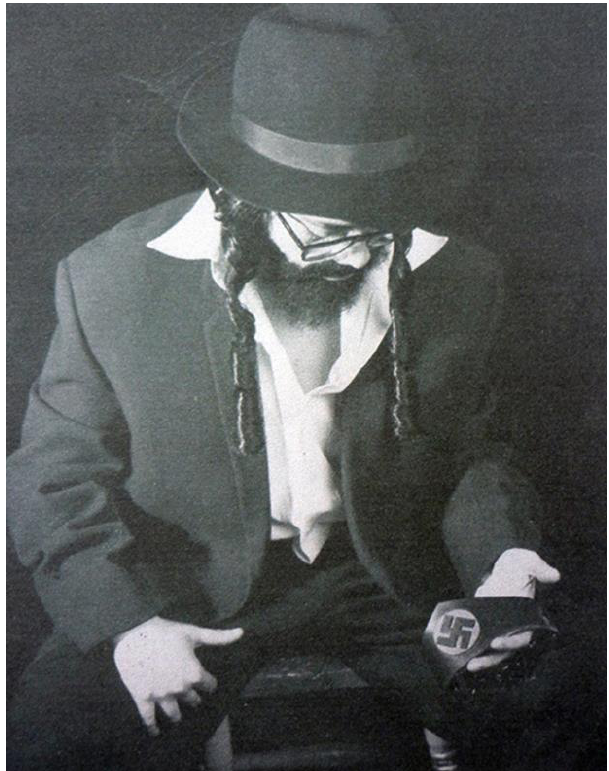
Figure 7. Oreet Ashery, Marcus Fisher III , circa 1998. Courtesy of the artist.